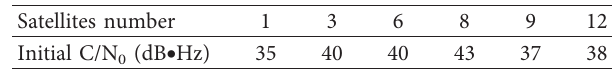
Table 1: Tracking satellite initial C/N 0 .